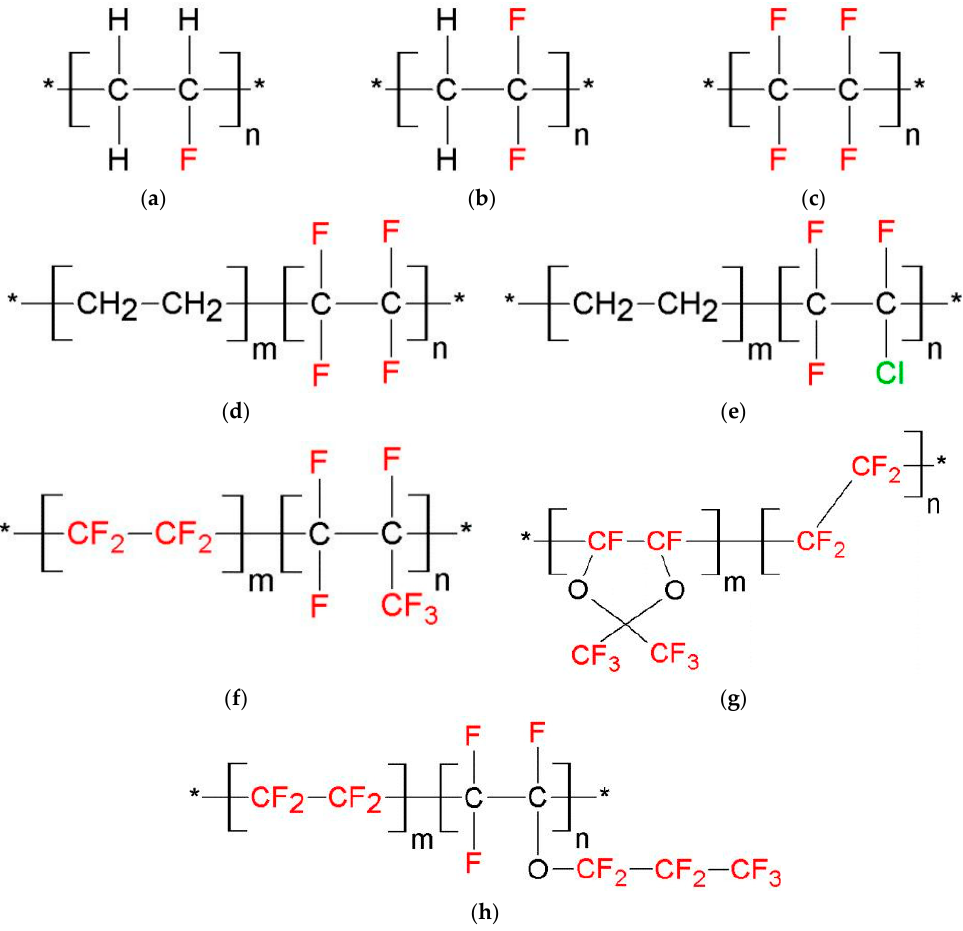
Figure 1. Molecular configuration of the polymers used in our study: ( a ) Polyvinyl fluoride (PVF); ( b ) Polyvinylidene fluoride (PVDF); ( c ) Polytetrafluoroethylene (PTFE); ( d ) Ethylene-tetrafluoroethylene copolymer (ETFE); ( e ) Ethylene-chlorotrifluoroethylene copolymer (ECTFE); ( f ) Tetrafluoroethylene- hexafluoropropylene copolymer (FEP); ( g ) Tetrafluoroethylene-perfluorodimethyldioxol (PDD) copolymer (Teflon ® AF2400); ( h ) Tetrafluoroethylene-perfluoropropylvinyl ether copolymer, perfluoroalkoxy (PFA).